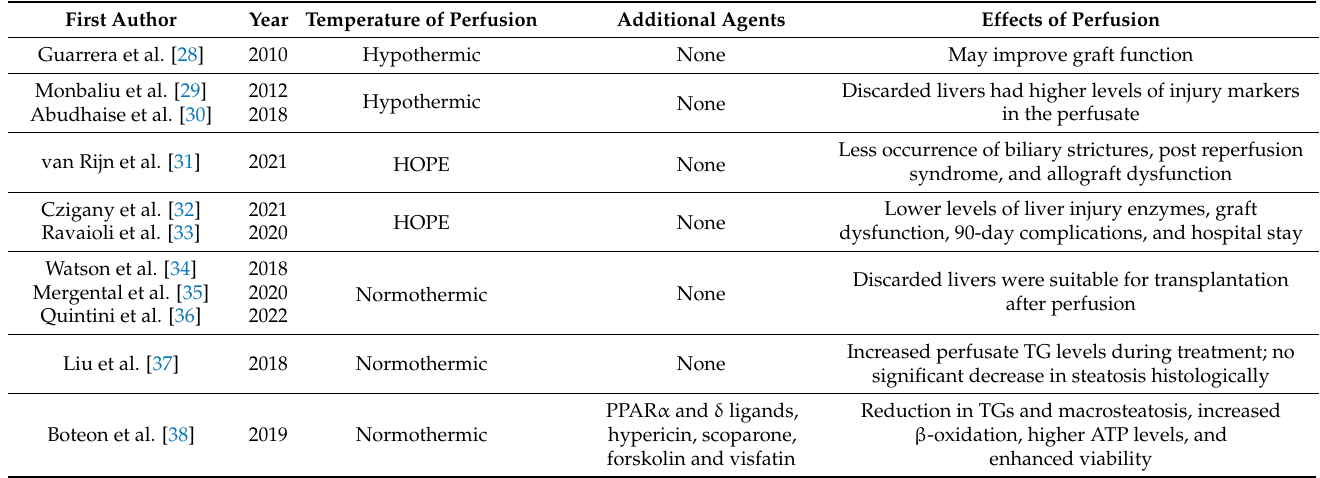
Table 3. Summary of Machine Perfusion Techniques–Clinical